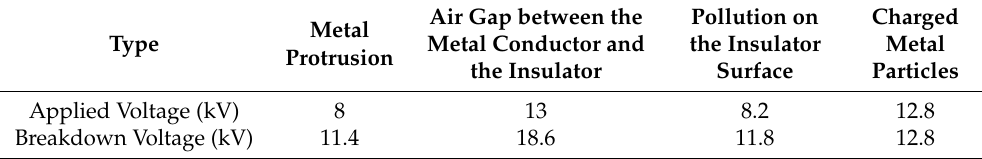
Table 1. The voltage applied for each defect. Type